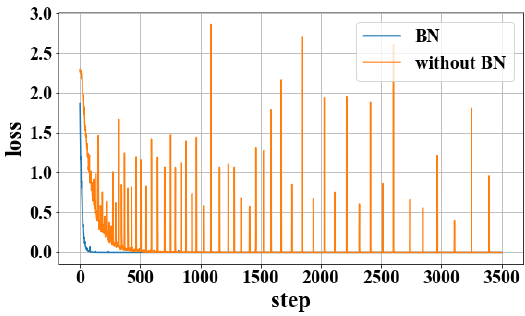
Figure 6. Loss function curve for without BN and BN.